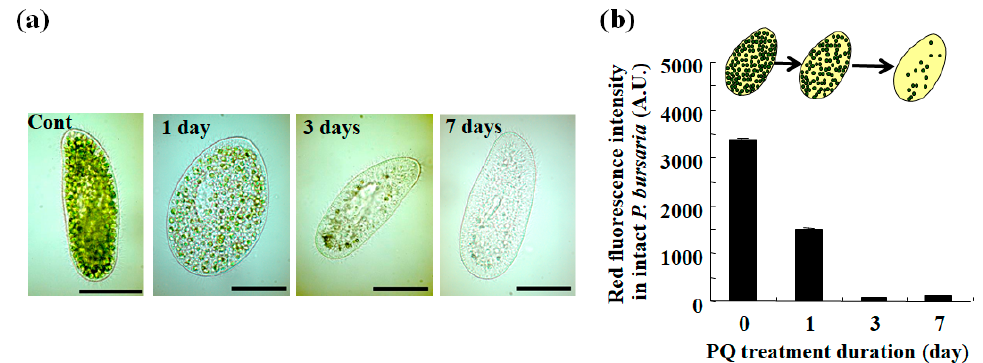
Figure 2. P. bursaria treated with the herbicide paraquat (PQ). ( a ) Photographs of representative P. bursaria cells treated or not (Cont) with 0.1 µg/mL of PQ for up to 7 d. Scale bar, 50 µm. ( b ) P. bursaria treated or not with PQ were analyzed using microcapillary FCM. The results are expressed as mean ± standard deviation ( n > 320 signals [320 cells of intact P. bursaria ]) in a bar graph of red fluorescence intensity.